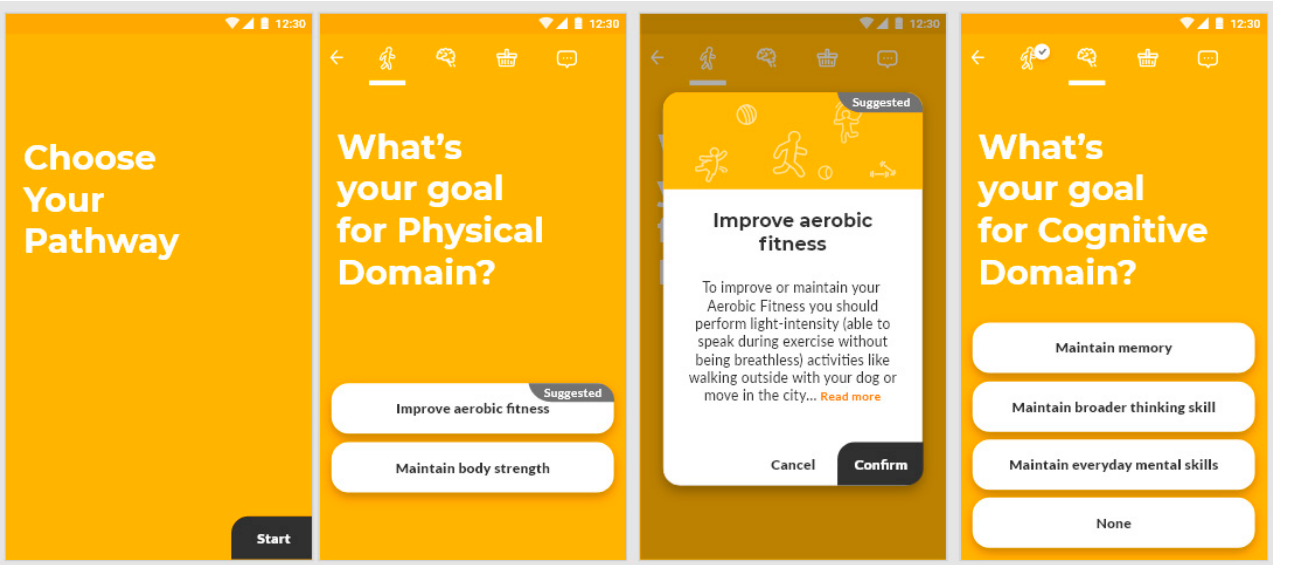
Figure 5. Pathway choice interface in the NESTORE Mobile app.